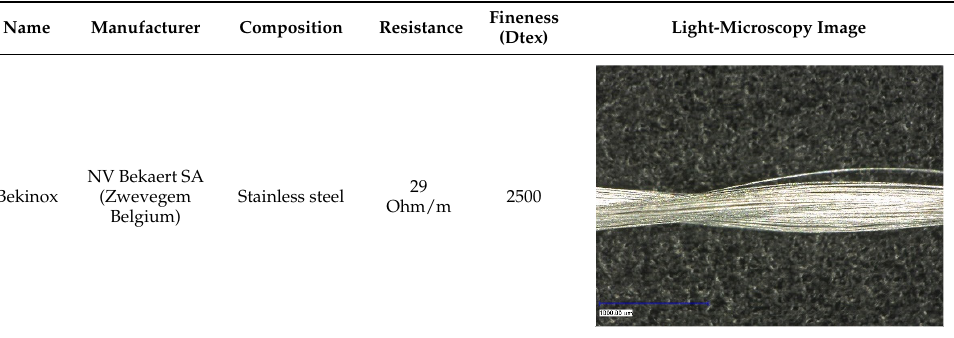
Table 1. Substrate metallic yarns for coating with conductive silicone.